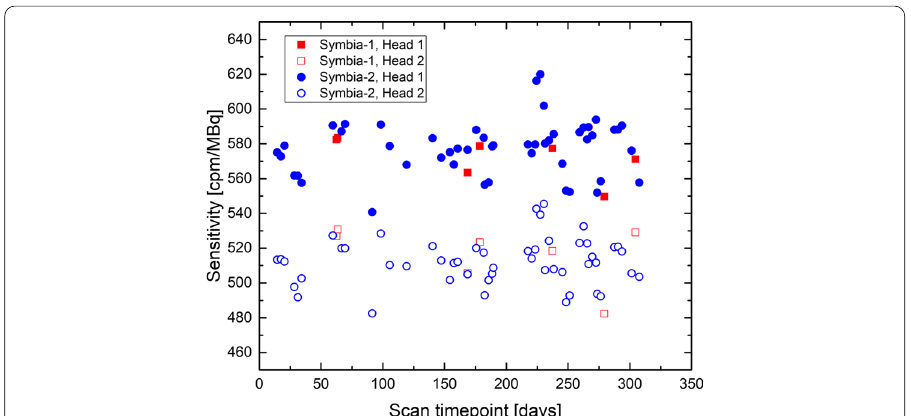
Fig. 5 Sensitivity as determined from static images of a 177 Lu standard. Head 1 was always above the patient board, while head 2 was below and therefore the sensitivity was reduced due to attenuation in the patient